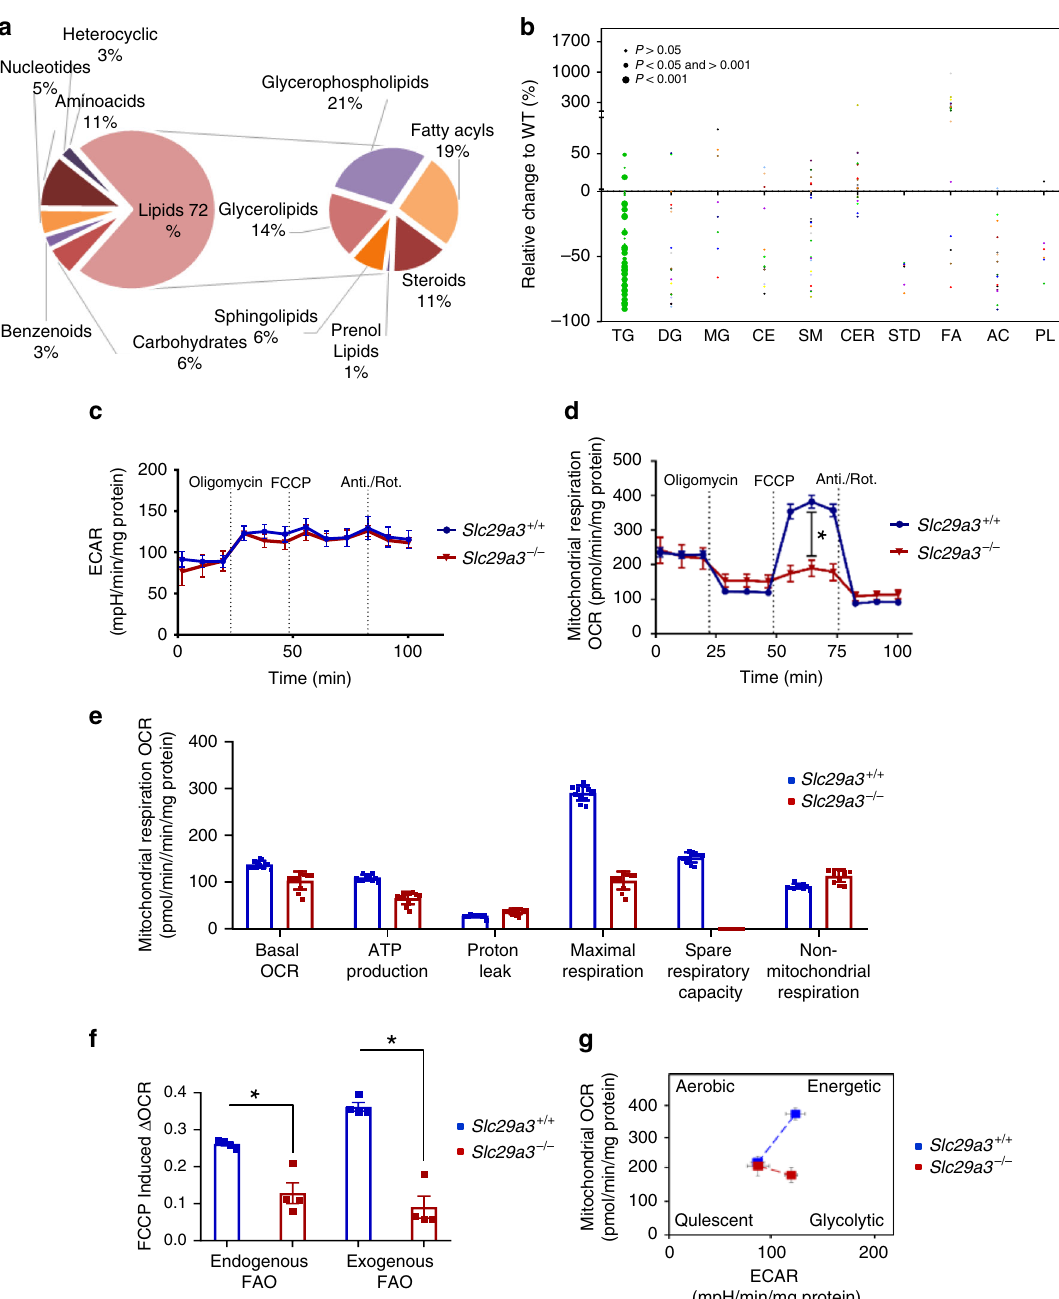
Fig. 8 Disrupted lipid homeostasis and altered fuel source selection in ENT3 de fi ciency. Pie-of-pie chart representation of total metabolites and those within the lipid superclass in the Slc29a3 − / − liver ( a ). Bubble chart representation of quanti fi ed lipids by targeted lipidomics (shown in Supplementary Fig. 9). Bubble, individual lipid; bubble size, signi fi cance (inset); n = 12 ( b ). Real-time measurements of the extracellular acidi fi cation rate (ECAR) ( c ) and oxygen consumption rate (OCR) ( d ) in Slc29a3 − / − MSCs ( n = 11, mean ± SEM). In addition to the basal levels, the fraction of OCR and ECAR contributing to ATP-linked OCR/ECAR measured by sequential injection of oligomycin, FCCP and antimycin/rotenone (Anti/Rot) are presented ( c , d ). Mitochondrial substrate utilization parameters in Slc29a3 − / − MSCs derived from c and d ( e ). Quanti fi cation of the oxidation of endogenous and exogenous palmitic acid ( n = 4, Slc29a3 + / + MSCs; n = 6, Slc29a3 − / − MSCs, mean ± SEM). FAO, fatty acid oxidation ( f ). Bioenergetics phenotype derived from the MitoStress test ( g ). Statistical analyses were performed using two-tailed Student ’ s t- test. * P < 0.05. Source data are provided as a Source Data fi le (DMEM) supplemented with 5% fetal bovine serum. These cells were transfected tartrate-resistant acid phosphatase (TRAP) using a leukocyte acid phosphatase with retroviral plasmid constructs harboring SLC29A3 or Δ N36 SLC29A3 18,20 for kit (Sigma-Aldrich, St. Louis, MO) or were subjected to visualization of actin ring formation using tetramethylrhodamine-phalloidin (Life Technologies, viral production. Cells were incubated with a complex containing 8 μ g of each of Carlsbad, CA) 53 . the plasmids, 24 μ l of FuGENE 6 reagent (Roche Applied Science), and 800 μ l of Opti-MEM serum-free medium (Invitrogen). After 48h of transfection, viruses in the supernatant were harvested, fi ltered, and target cells were transduced with Retroviral production and transduction . A retroviral packaging cell line (ATCC, recombinant viruses at 4 μ g/ml polybrene to virus concentration. CRL 9078) was maintained in Dulbecco ’ s modi fi ed minimum essential medium NATURE COMMUNICATIONS| (2019) 10:2943